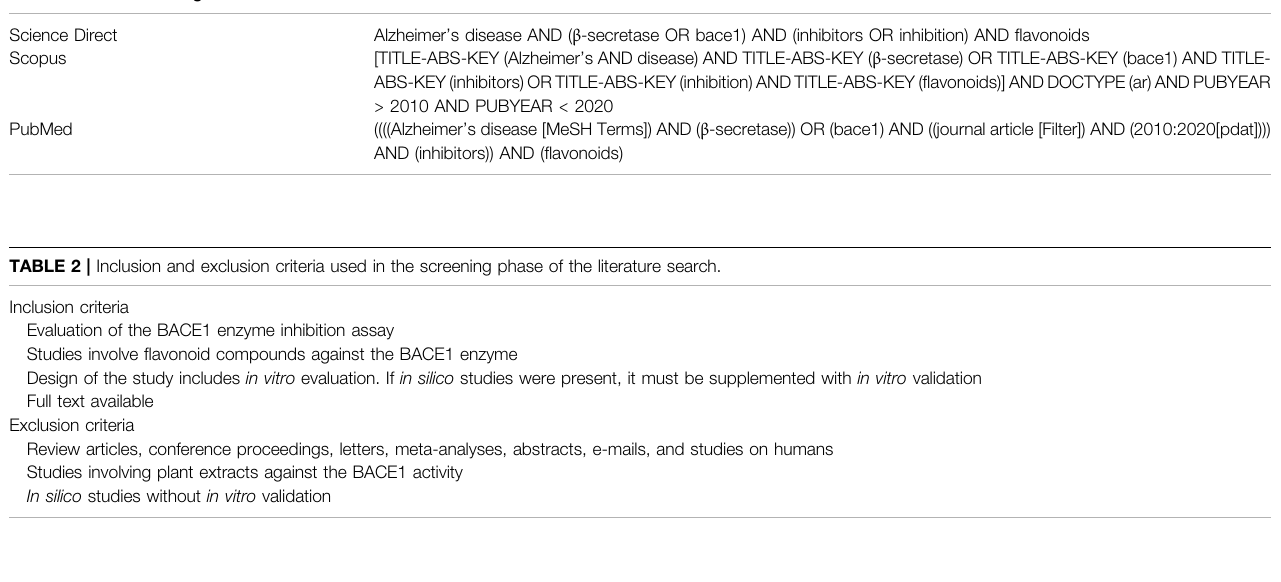
TABLE 1 | Search string used for each database to search for relevant literatures. Database search string Science Direct